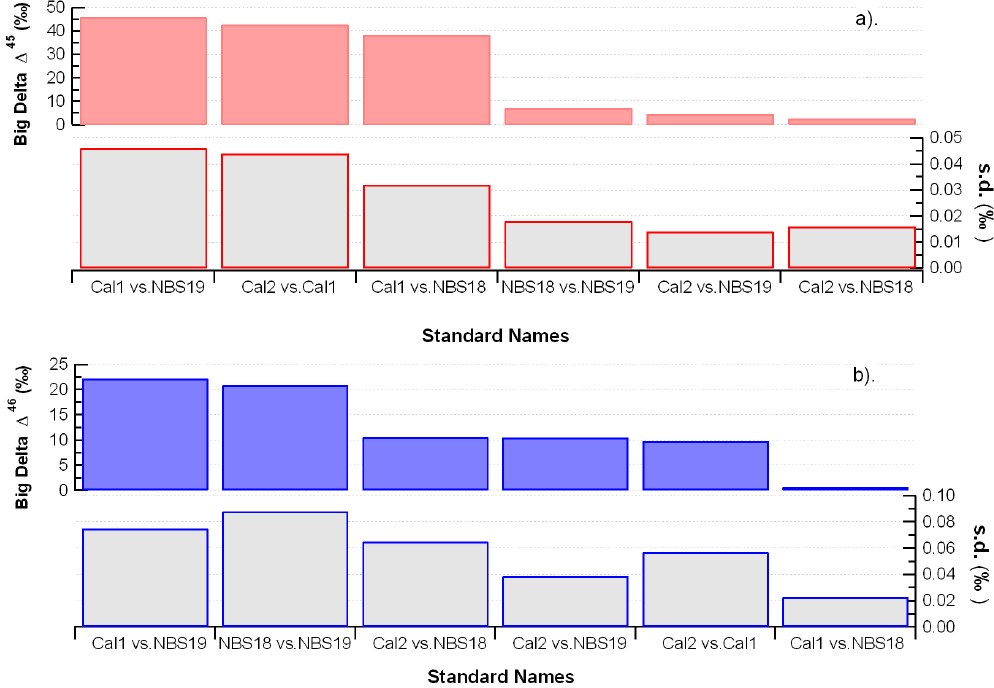
Fig. 3. There is a positive correlation between the absolute Big Delta values and the corresponding standard deviations in both carbon (top panel) and oxygen (bottom panel) isotopes. The coefficient of determination ( r 2 ) is 0.94 and 0.63 for 1 45 and 1 46 , respectively. The absolute Big Delta value of the primary anchor (Cal2) relative to NBS19 is ∼ 4.59 ‰ in 1 45 (s.d.: 0.01‰) and ∼ 10.54‰ in 1 46 (s.d.: